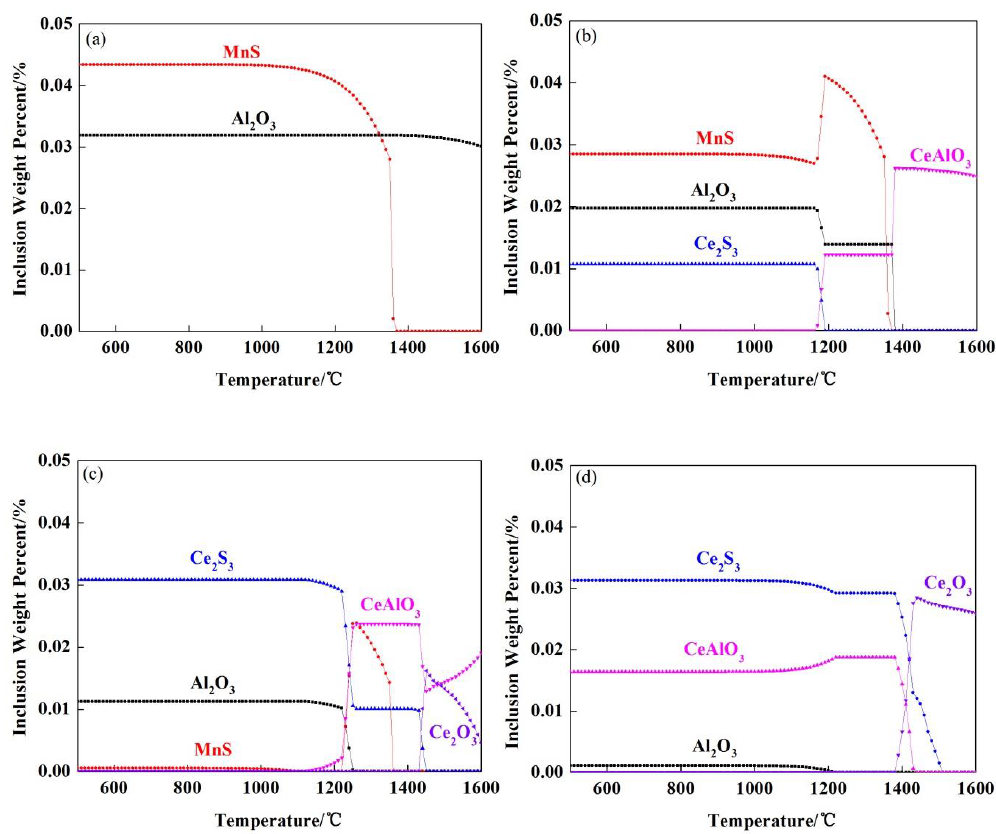
Figure 7. Calculation results by thermodynamic software. E ff ect of cerium addition on inclusions, ( a ) w(Ce%) = 0; ( b ) w(Ce%) = 0.008%; ( c ) w(Ce%) = 0.023%; ( d ) w(Ce%) =